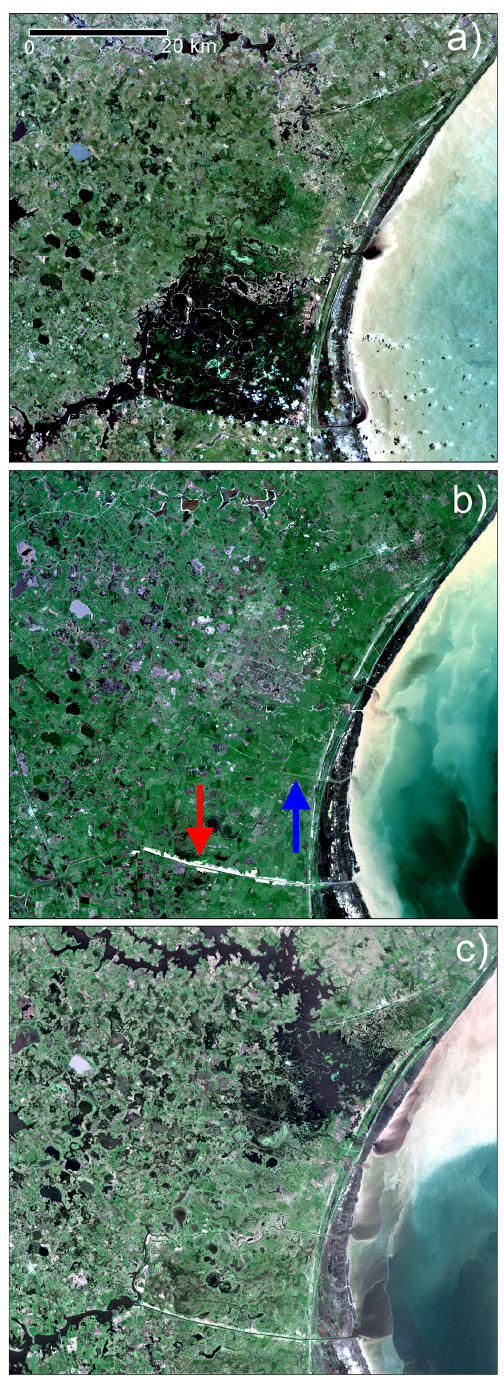
Fig. 3. Landsat images of the central sector of the Samboromb´on coastland acquired on (a) 13 January 1986, (b) 7 October 1996, and (c) 11 September 2001. (a) highlights the occurrence of a severe flooding of the Rio Salado; in (b) the dredging of the Canal 15 and the new Ancillary Canal are evidenced by the red and blue arrows, respectively; (c) shows a flooding caused by the Rio Samboromb´on.